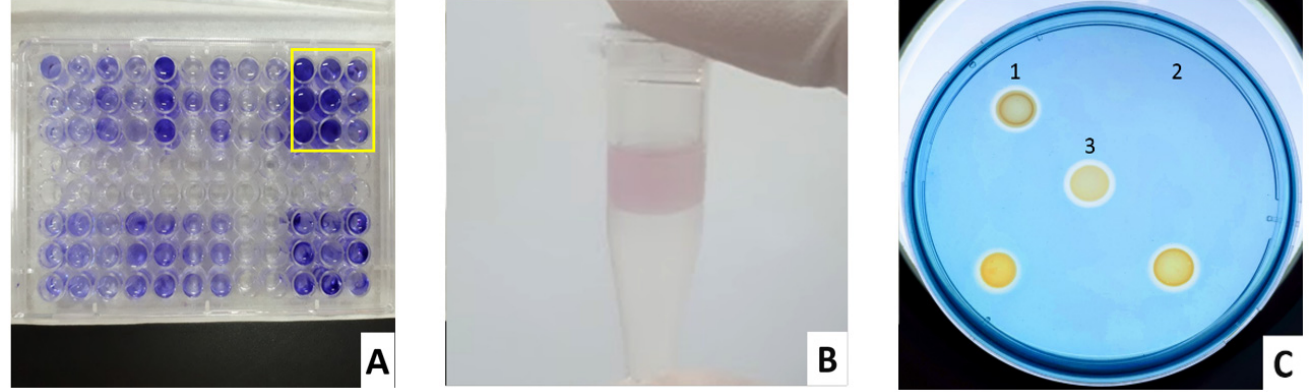
Figure 1. The production of biofilm ( A ), pyocyanin ( B ) red layer in 0.2 N HCl, and ( C ) siderophores of commensal P. aeruginosa isolates. ( A ): yellow rectangle— P. aeruginosa ATCC 9027; others— P. aeruginosa isolates; C1: E. coli , C2: S. aureus , C3: P. aeruginosa ATCC 9027; others— P. aeruginosa isolates. HDTMA in CAS agar was toxic to Gram-positive bacteria, so S. aureus was inhibited and did not grow at the C2 position. Table 3. Production of biofilm, pyocyanin, siderophores, lipase, protease, and gelatinase in com- mensal P. aeruginosa isolates and P. aeruginosa ATCC 9027.